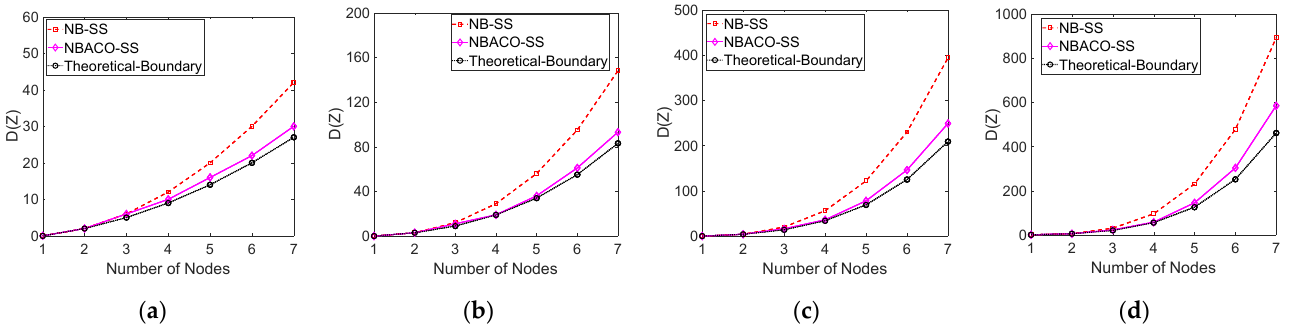
Figure 4. Simulation of solution space continuity of NBACO-SS algorithm: ( a ) length = 4; ( b ) length = 5; ( c ) length = 6; ( d ) length =